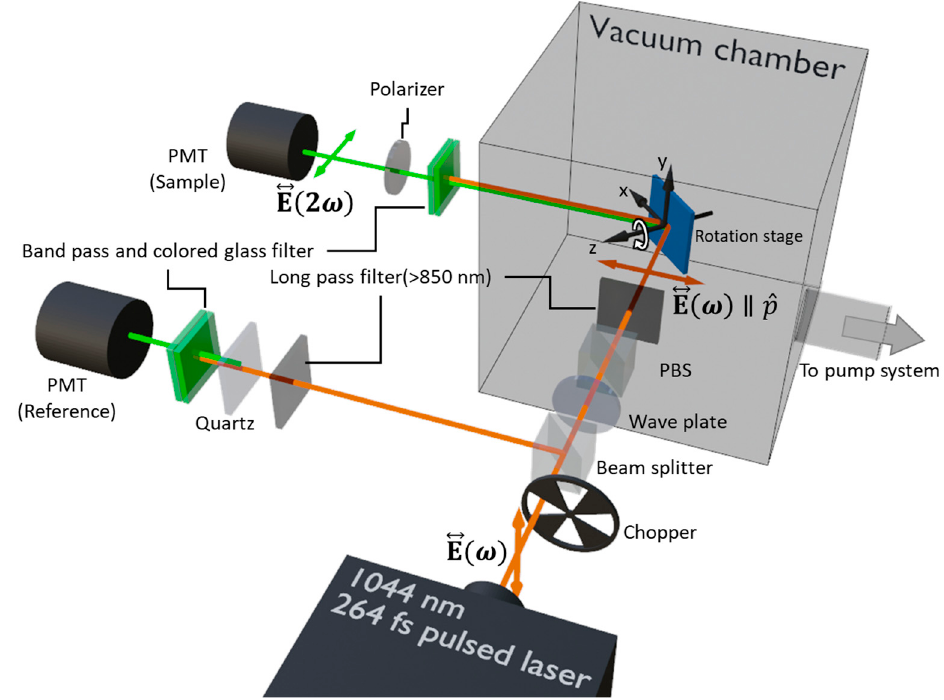
Figure 6. Experiment setup for Ani-RSHG measurement in a vacuum.